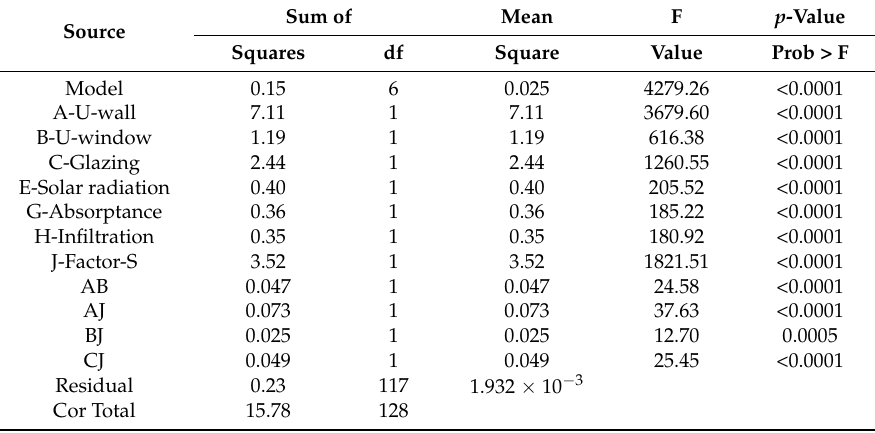
Table 10. Analysis of variance (ANOVA) of selected model for Delta ( OIT H ).